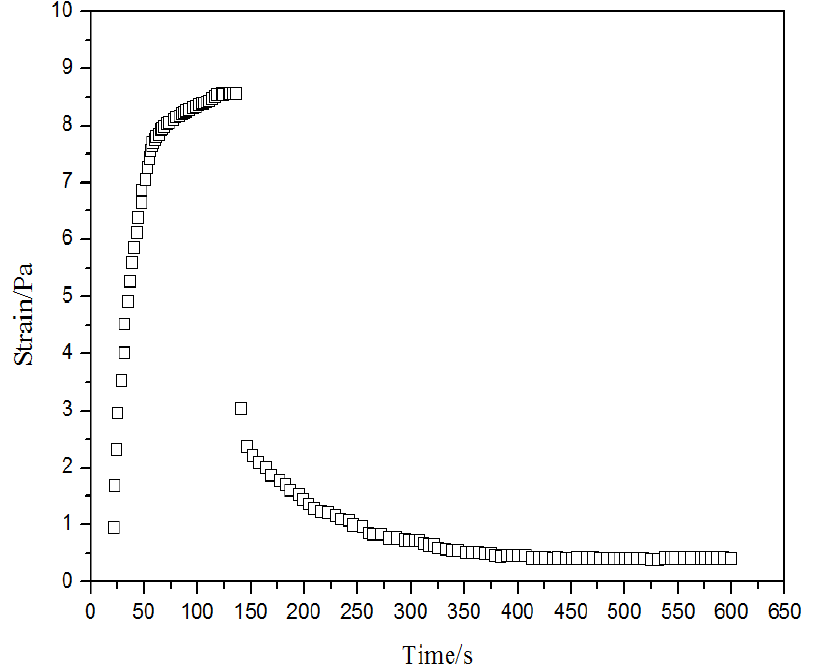
Figure 9. Elastic characteristics of the gel system at 55 °C.